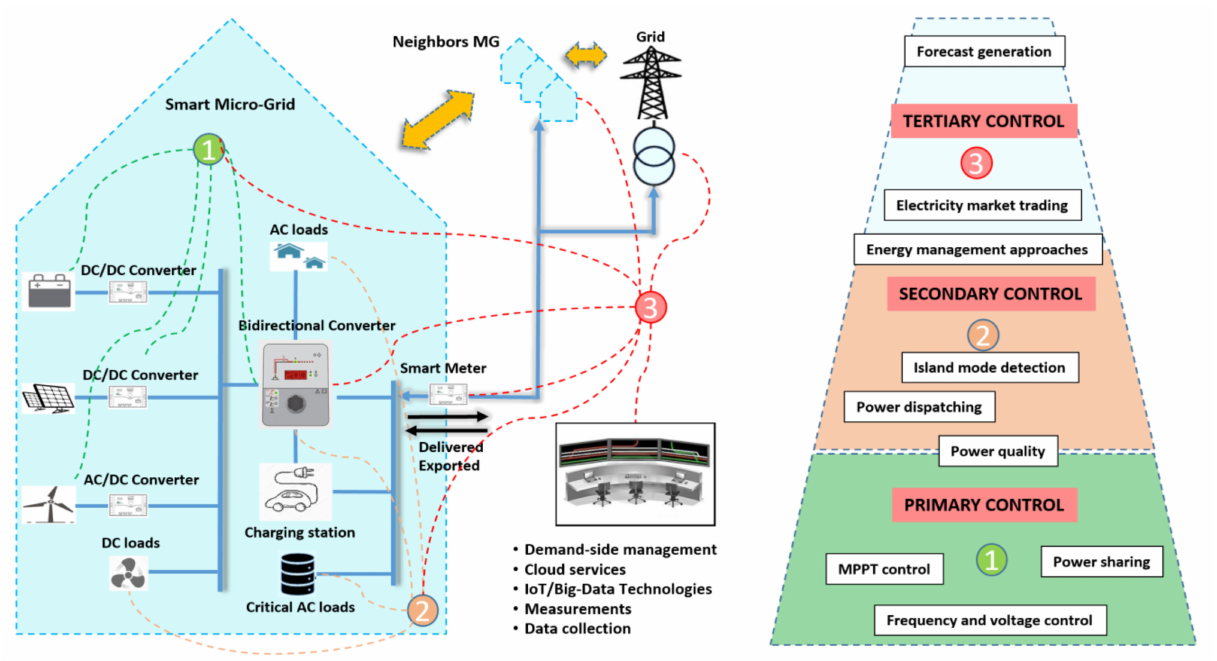
Figure 2. Micro-grid energy management